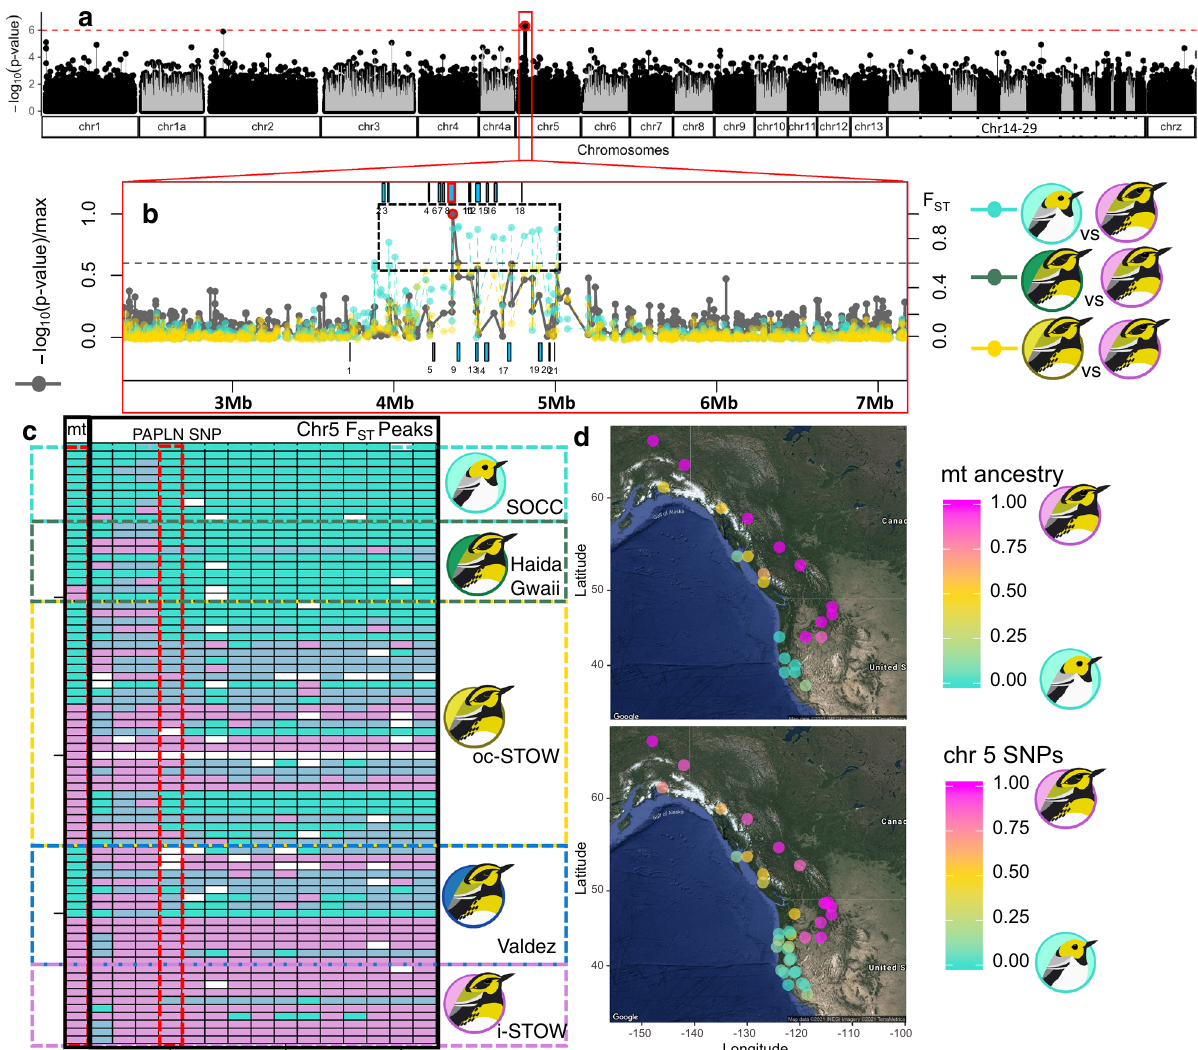
Fig. 4 Mitonuclear association across SOCC, coastal STOW, and inland STOW populations. a – c Mitonuclear association coincides with F ST peaks between S. occidentalis (SOCC) and inland S. townsendi (inland STOW), as well as between various coastal STOW versus inland STOW. a GWAS scan of mitonuclear association (controlling for population substructure) across the genome revealed signi fi cant associations ( p corrected <10 − 6 indicated by red circles) within chromosome 5. b The mitonuclear association (red circle) within chromosome 5 coincides with F ST peaks ( F ST >0.6) between inland STOW (magenta logo) and SOCC (turquoise logo), between Haida Gwaii STOW (forest green logo) and inland STOW, as well as between other coastal STOW (yellow logo) and inland STOW. The colors of the F ST scans are consistent with the color logos of the populations that were compared with inland STOW. Blue boxes correspond to the positions of genes (top: forward strand; bottom: reverse strand) corresponding to the numbered IDs in Supplementary Data 1. The mitonuclear association peak is within Papilin, proteoglycan like sulfated glycoprotein (PAPLN) highlighted with red border. c Ancestry genotypes (turquoise = SOCC; light blue = heterozygous; magenta = inland STOW) of mitochondrial ND2 and chr5 SNPs correspond to strong genotypic differences between populations. Ten randomly sampled individuals from each parental population were shown along with the individuals from various coastal STOW. The PAPLN SNP genotypes are red bordered. d There is signi fi cant correlation between site mean ancestry of mtDNA (top, same as Fig. 1b) and chr5 (bottom) genetic block (shown in c ) after controlling for geographical distance across sites (partial mantel test, p <10 − 4 ). Each data point represents a sampling site. Map data ©2019 Google. Bird illustrations by Gil Jorge Barros